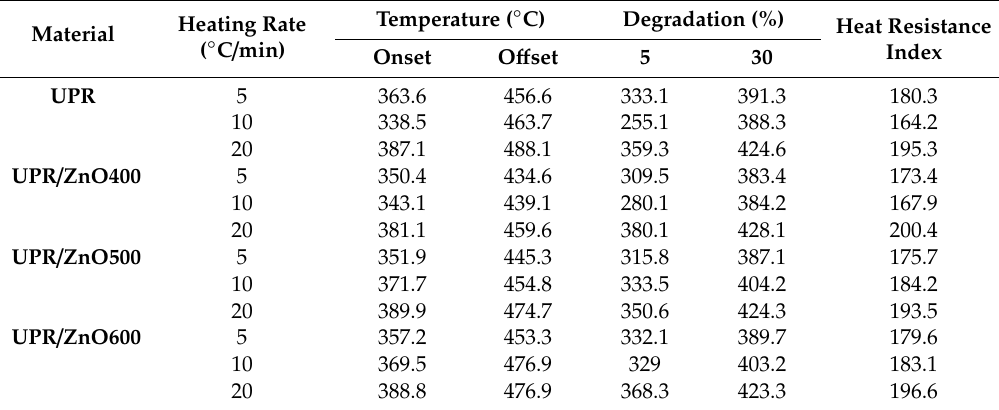
Table 2. Transition temperatures obtained from the DTG